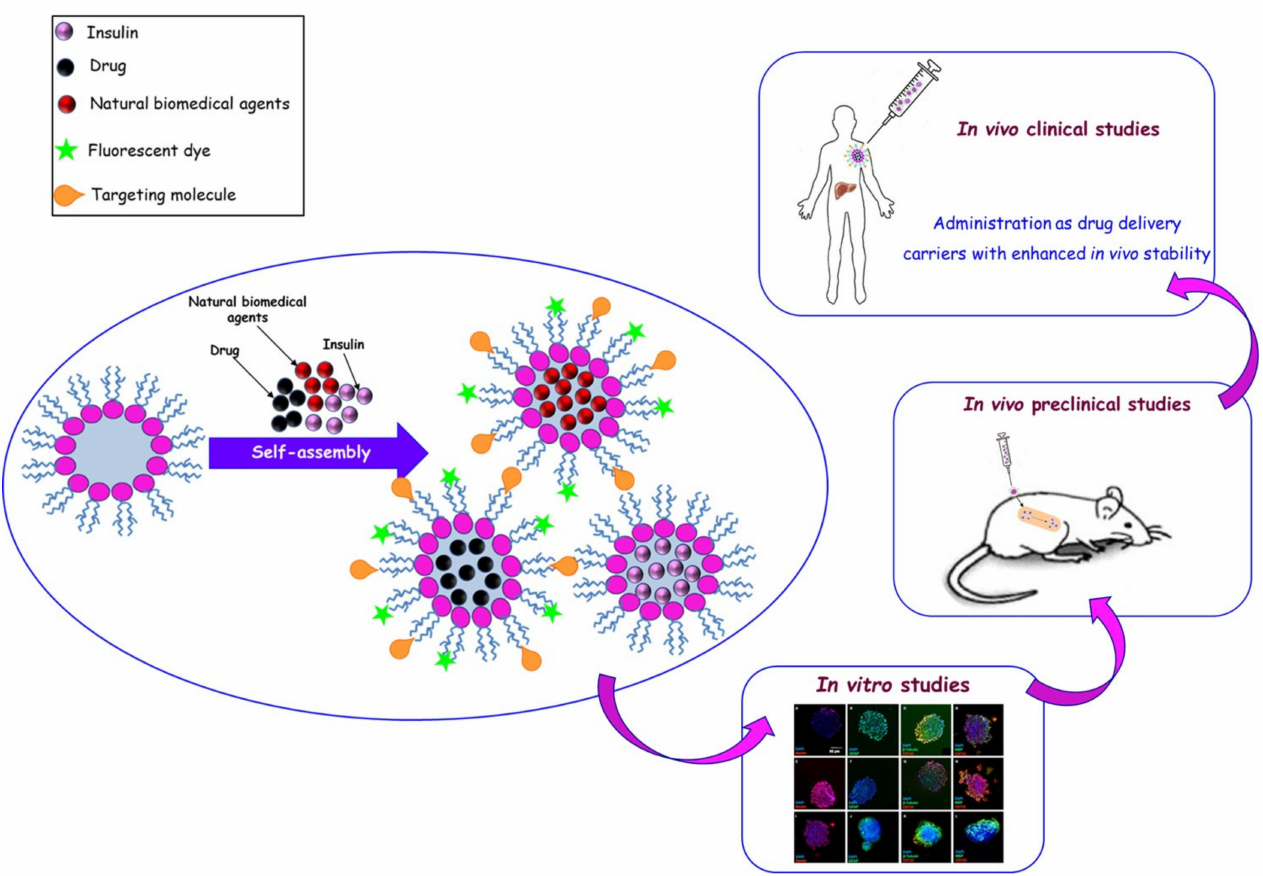
Figure 11. Development of delivery systems using reverse